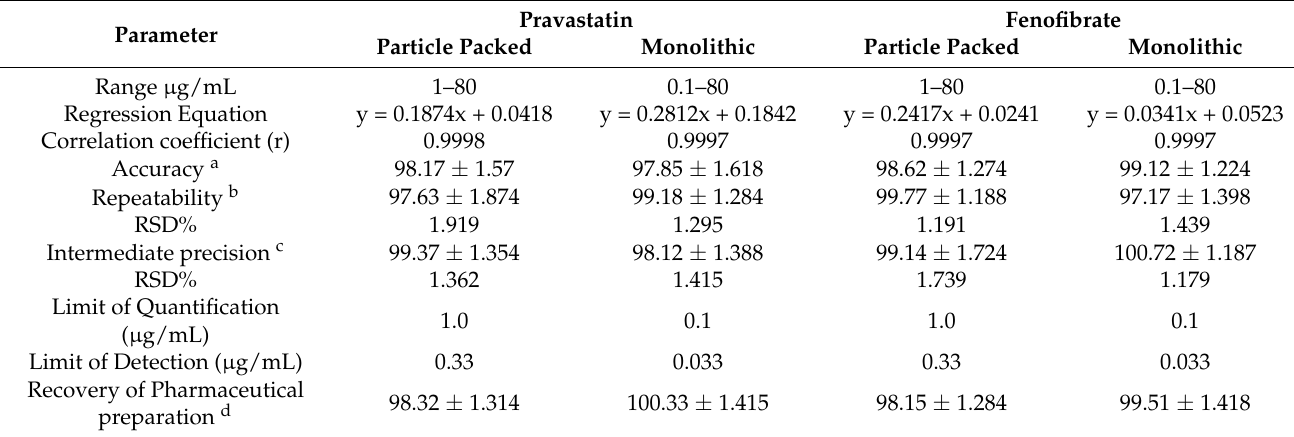
Table 3. Validation specifications and an assay of pharmaceutical formulation by the proposed methods.